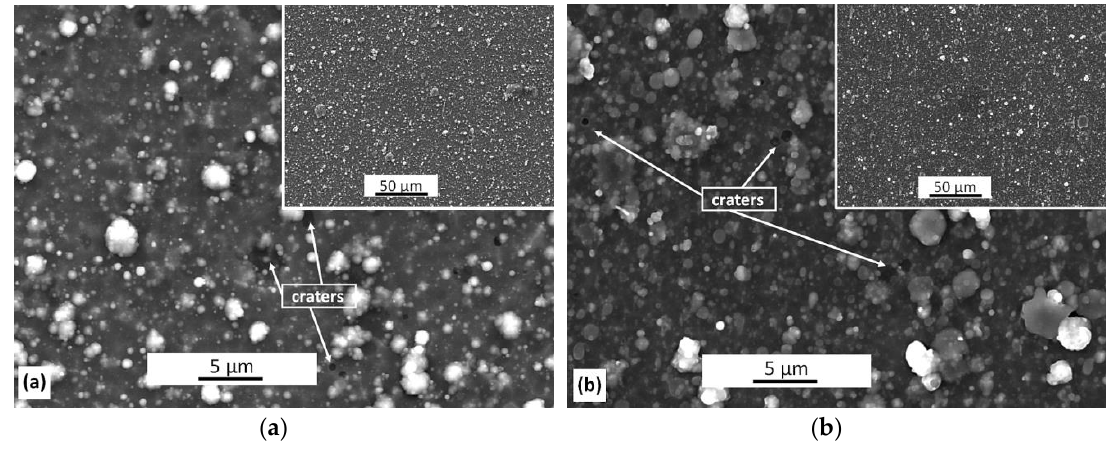
Figure 1. Morphology of: ( a ) AlCrN and ( b ) AlCrSi(10)N coatings.